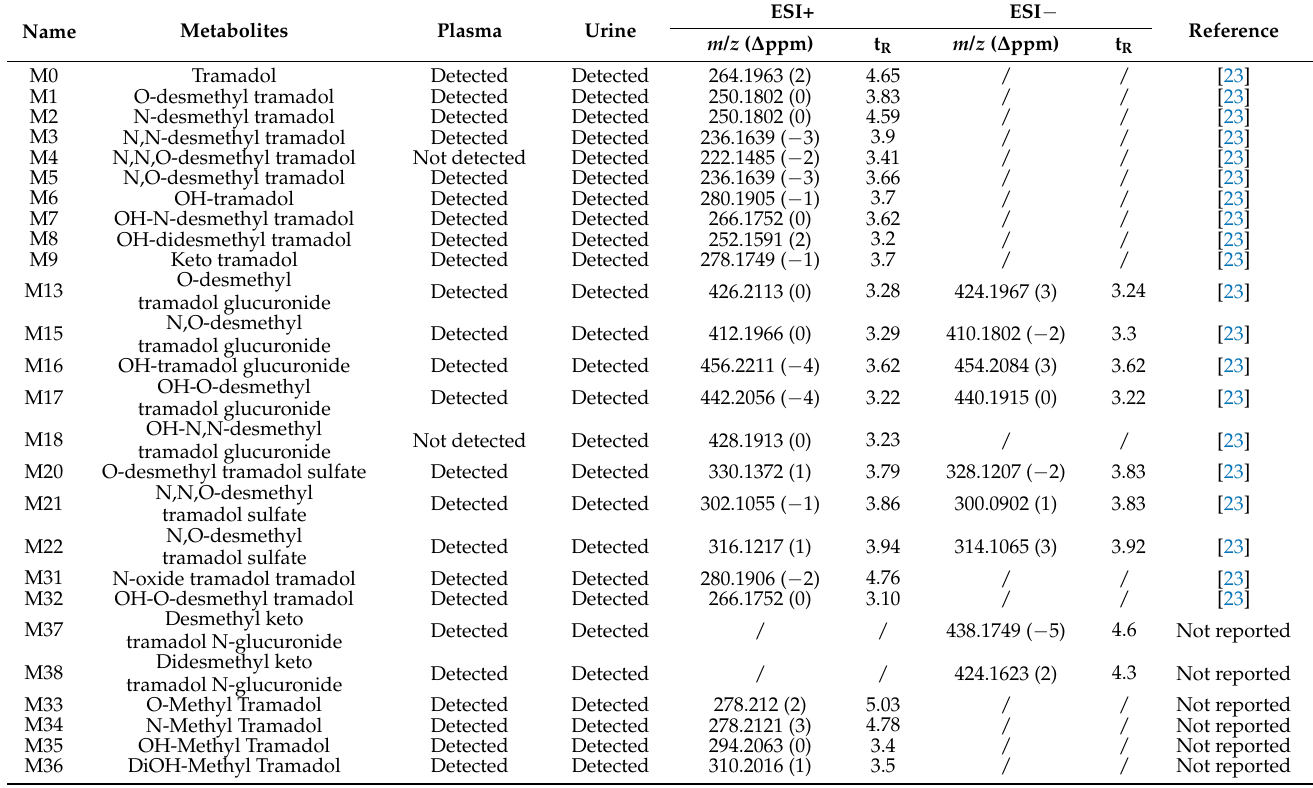
Table 1. Analytical features of tramadol and its metabolites detected in plasma or urine of the intoxicated